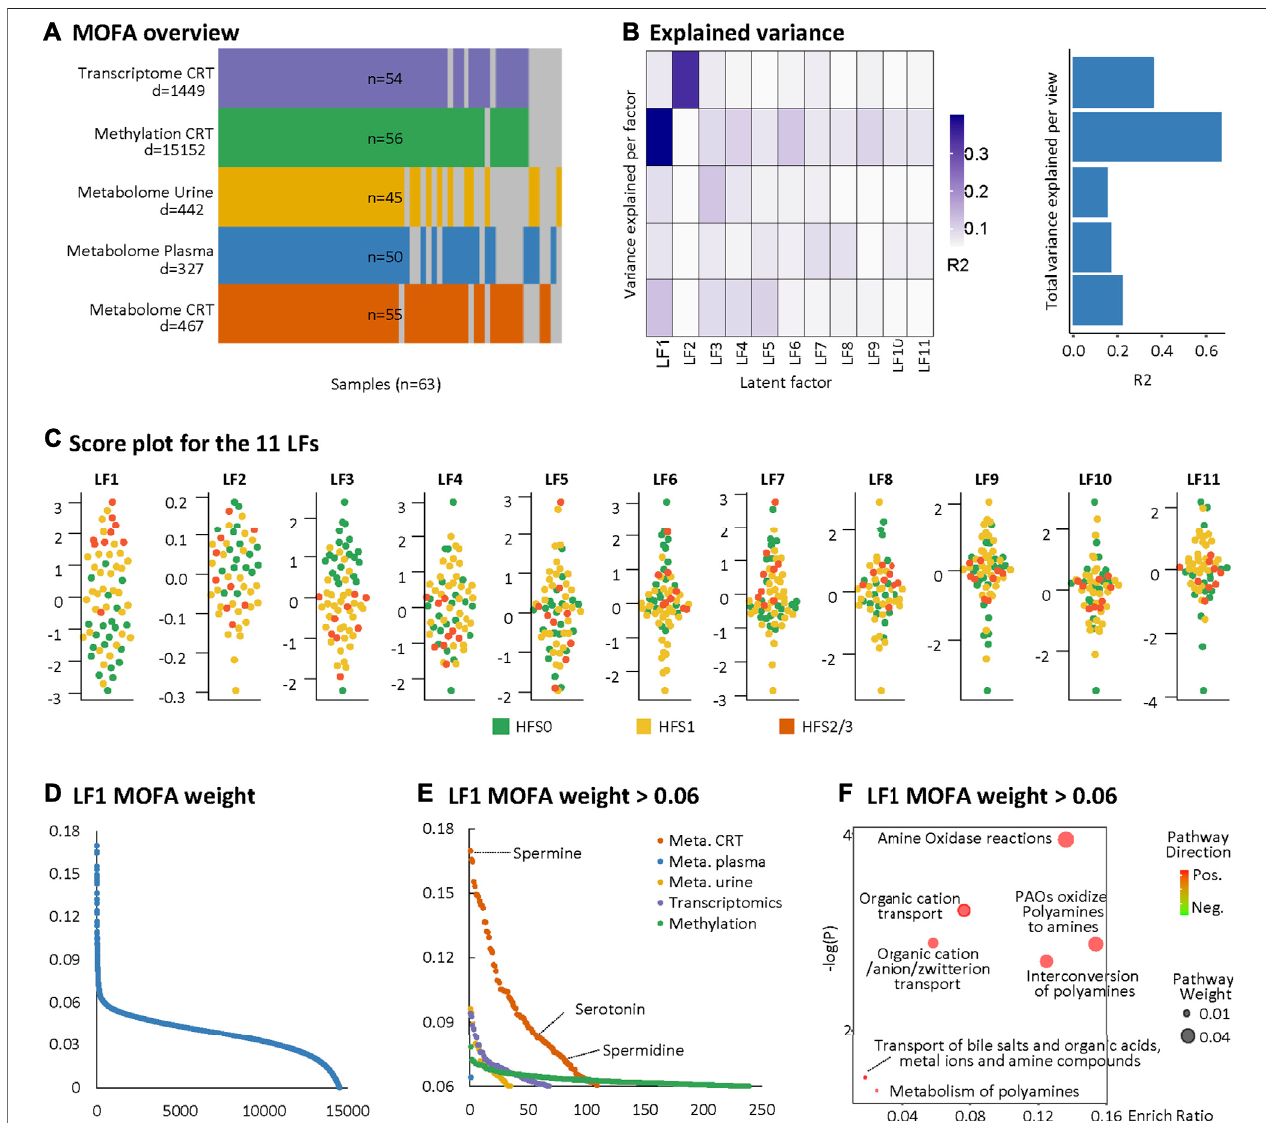
FIGURE 2 | Multi-omics factor analysis (MOFA). MOFA captured 11 latent factors (LFs) from the multi-omics datasets. (A) MOFA overview listing the number of samplesanddifferentiallyexpressedfeatures(DEFs)fromeachomicsdataset. (B) Explainedvariance(R2)byeachLF(left)andthecumulativeproportionoftotalvariance explained (right) for each omics dataset of the MOFA model. (C) Score plots for the 11 LFs. The y -axis represents the each LF score for each sample. Colors denote sample groups. (D) The distribution of features based on the LF1 weight of the MOFA model. (E) The distributions of features with LF1 MOFA weight above the threshold of 0.06 from each omics dataset. (F) Pathway enrichment analysis of DEFs with LF1 MOFA weight > 0.06 (in HFS2/3), including CRT metabolome and CRT transcriptome. Cutoff: the minimum number of DEFs enriched in the pathway was set as 2, the p -value was set as 0.05, and – log10(P) was used for visualization. Pathwayweightisde fi ned as:(Enrichmentratio) × (sumofabsolutevalueofDEFMOFAL1weight inthepathway),andthedotsizerepresentspathway weight.Pathway directionisthemedianfoldchange(FC)ofDEFsforeachdatasetinthepathway(red,upregulated;green,downregulated).Abbreviations:LF,latentfactor;MOFA, Multi- omics Factor